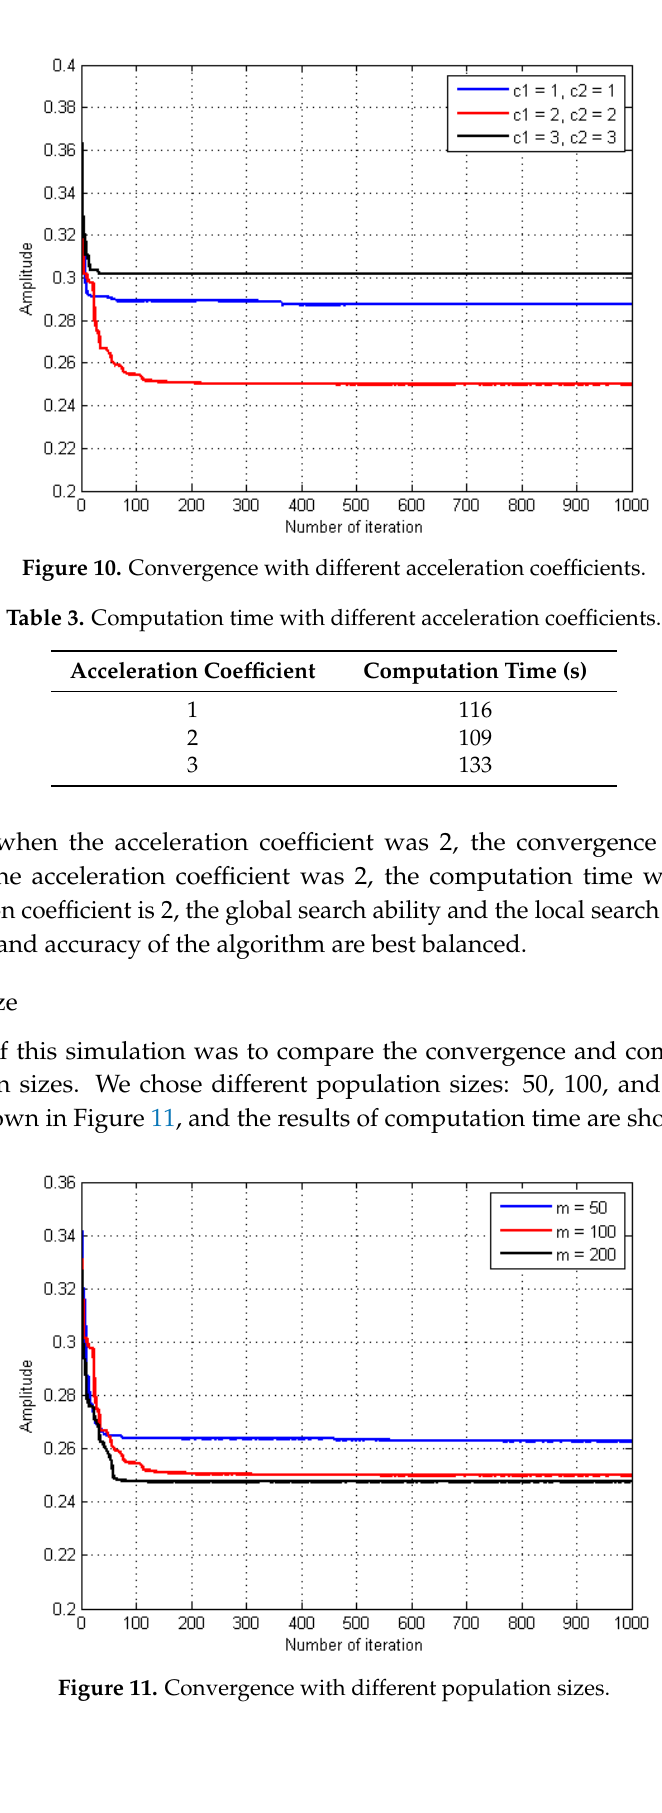
Figure 12. Convergence of PSO and genetic algorithm (GA).